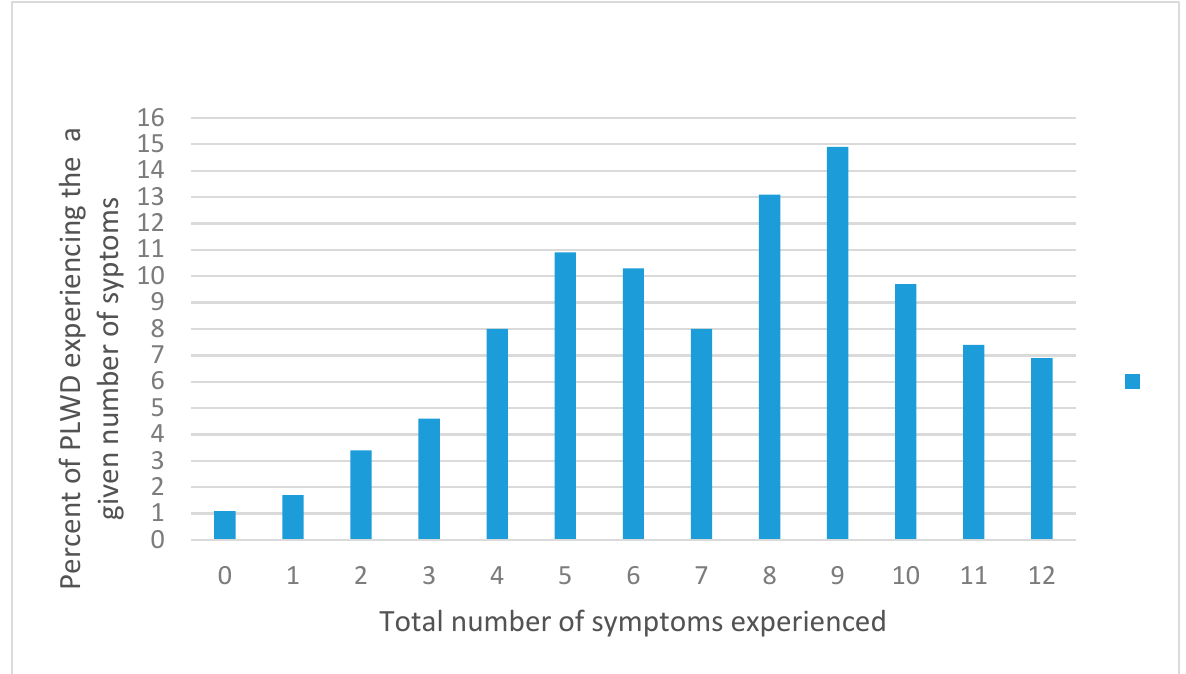
Figure 1. Frequency of behavioral and psychological symptoms of dementia among people living with dementia.